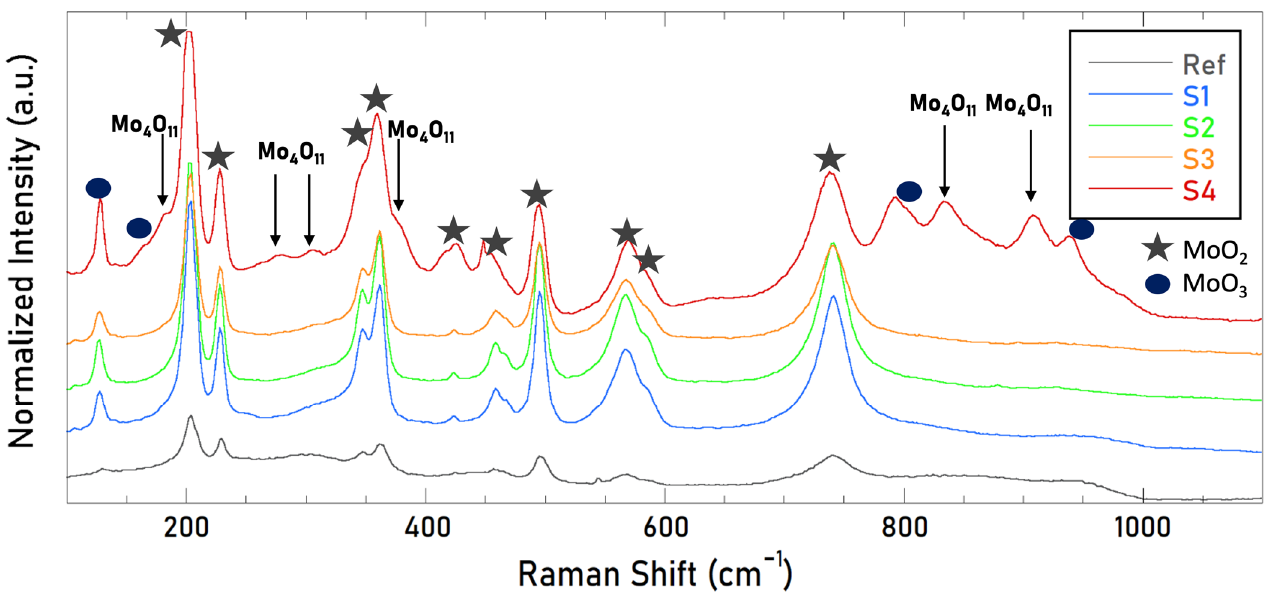
Figure 15. Raman spectra of the four nanotextured samples after the thermal annealing. Bands related to the Mo 4 O 11 specie are highlighted for the S4 spectra.